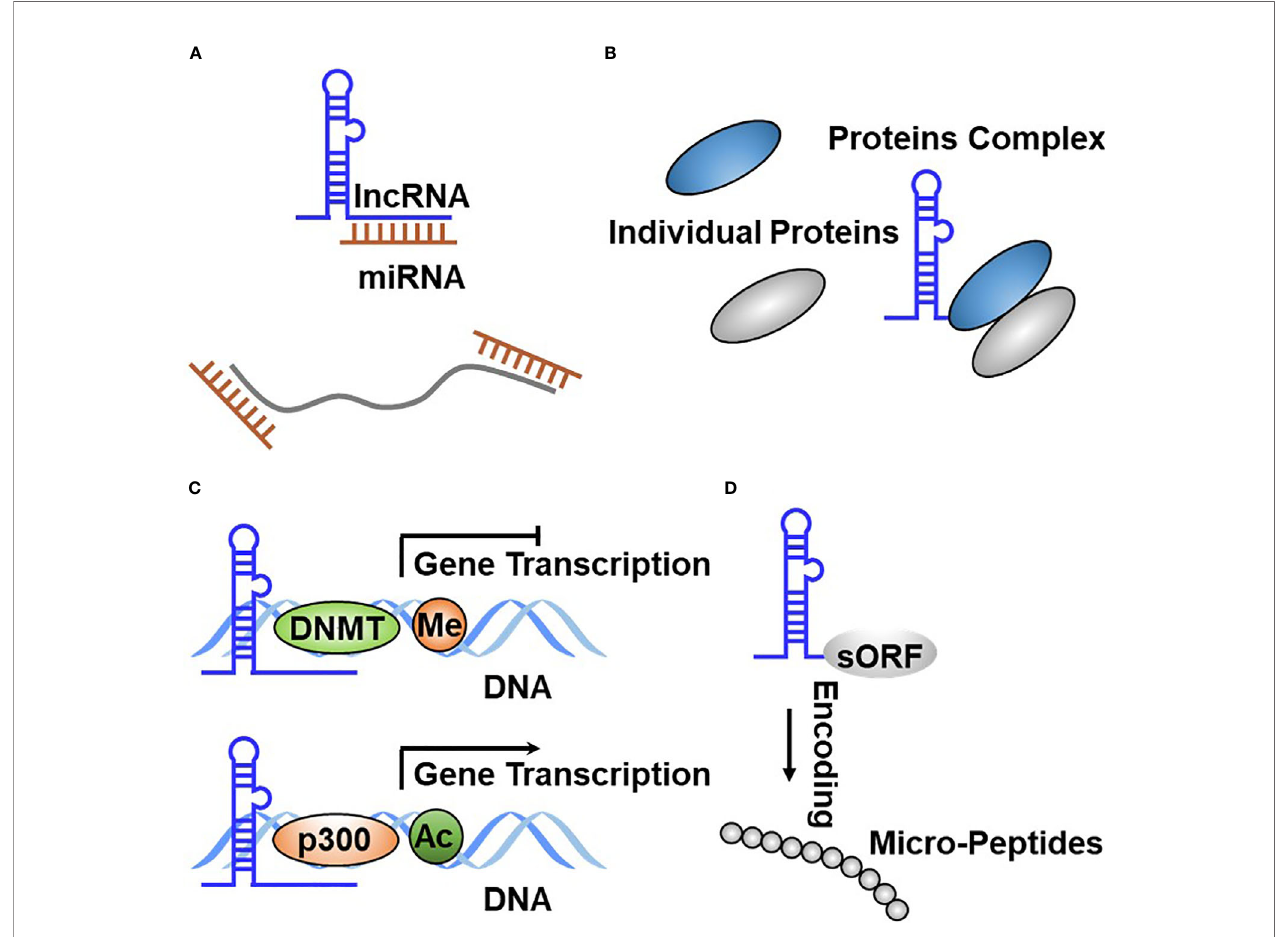
FIGURE 3 | Functional principles of lncRNA in TC. (A) LncRNA directly binds to miRNA through complementary base pairing. (B) LncRNA binds to protein to form the RNA – protein complex. (C) LncRNA regulates gene expression at the transcriptional through binding to DNA through complementary base pairing. (D) LncRNA encodes the small